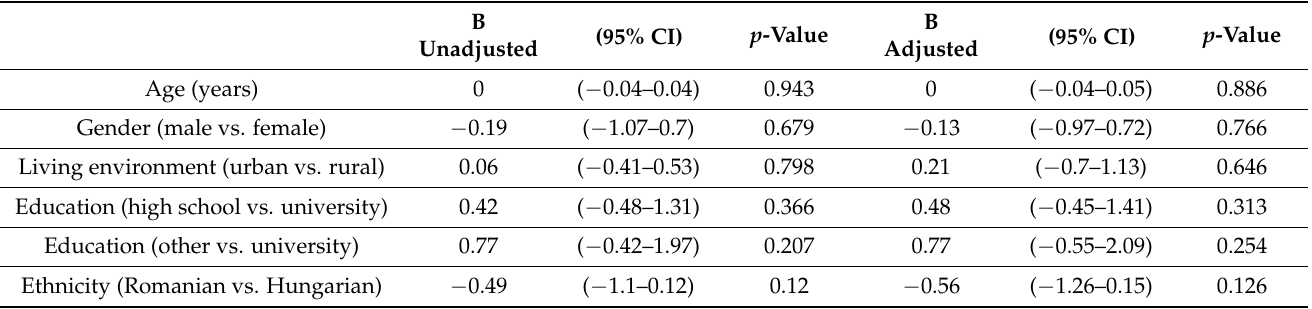
Table 6. Simple and multiple linear regression models predicting lie score differences (pre-COVID-19 versus COVID-19